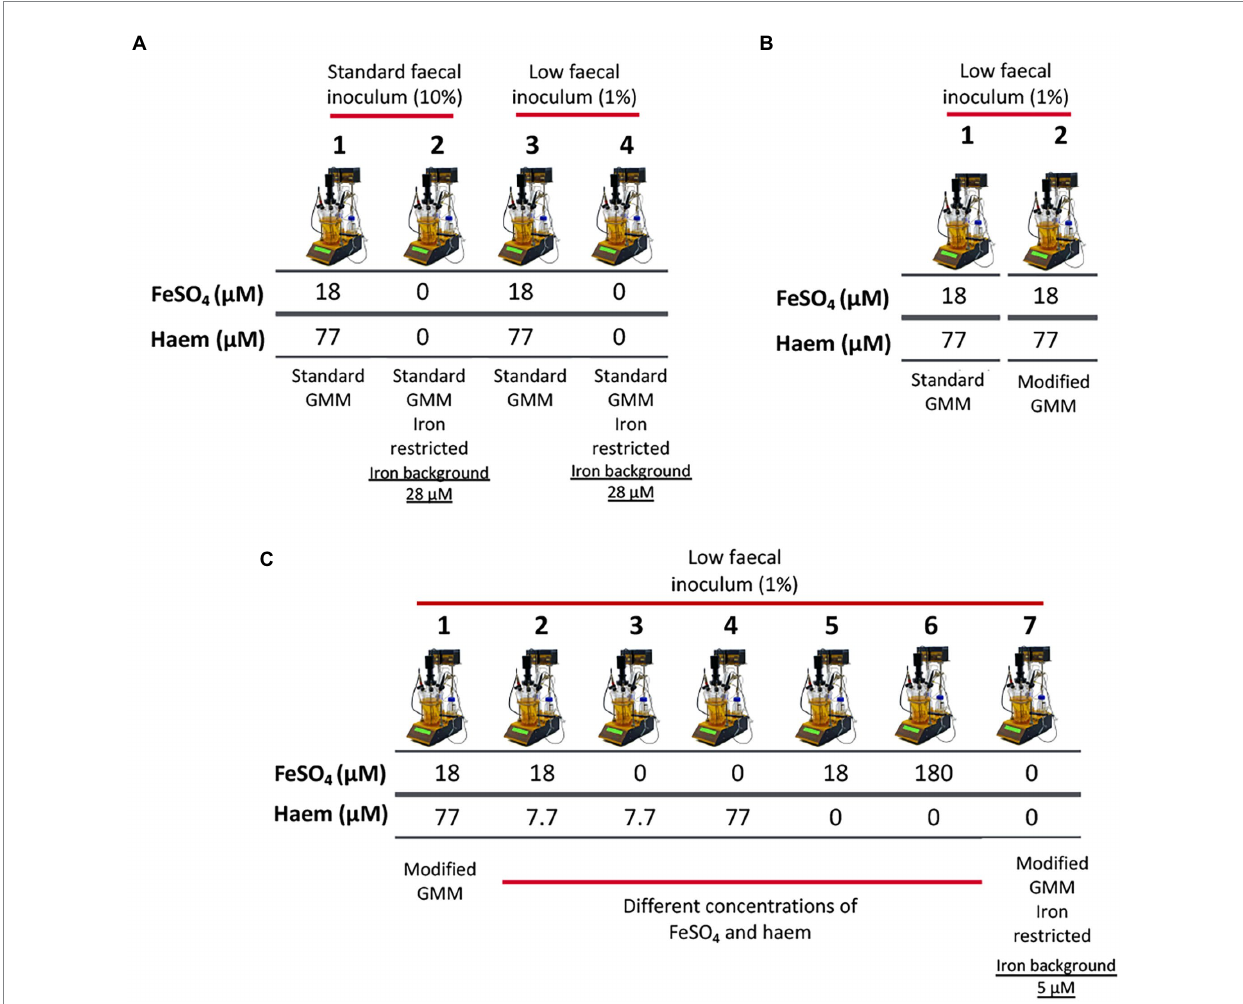
FIGURE 1 Schematic representation of experimental conditions employed in single-stage anaerobic batch gut-culture systems. (A) The impact of iron sources